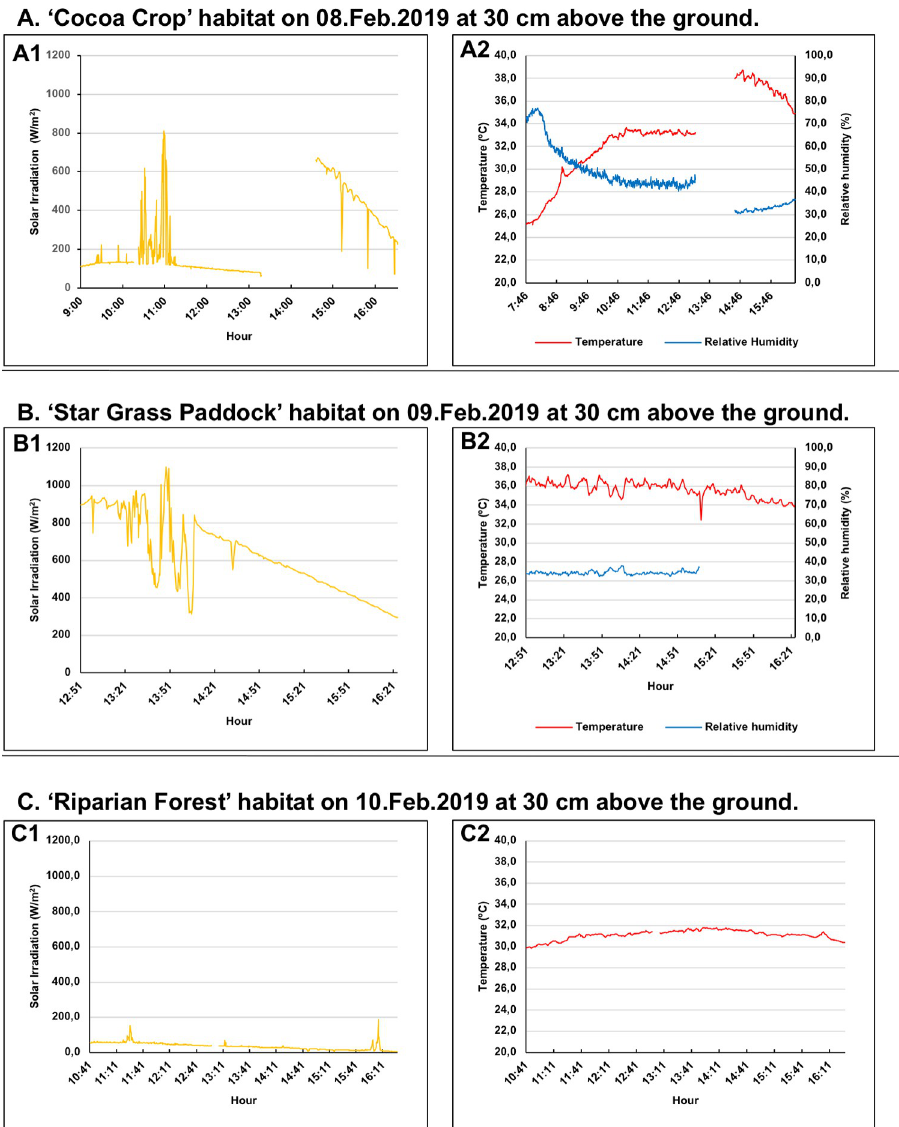
Fig 6. Plots of microclimatic variables that were measured in situ for three habitats in the dry season. (A). Cocoa Crop habitat. (A1). Solar irradiation values (W/m 2 ) (N = 736; � w � = 243.5; SD = 189.1; Max = 810.6; Min = 59.4) according to the daytime hours. (A2). Temperature values (˚C; red line) (N = 901; � w � = 32.7; SD = 3.6; Max = 38.7; Min = 25.1) and relative humidity (%; blue line) (N = 901; � w � = 45.9; SD = 11.6; Max = 76.9; Min = 30.4) according to the daytime hours. (B). Star Grass Paddock habitat. (B1). Solar irradiation values (W/m 2 ) (N = 427; � w � = 629.1; SD = 199.6; Max = 1,096.9; Min = 295.6) according to the daytime hours. (B2). Temperature values (˚C; red line) (N = 427; � w � = 35.6; SD = 0.8; Max = 37.2; Min = 32.4) and relative humidity (%; blue line) (N = 276; � w � = 34.4; SD = 1.0; Max = 38; Min = 32.3) according to the daytime hours. The relative humidity variable was not measured during the same period of time than temperature because of a damage in the respective sensor. (C). Riparian Forest habitat. (C1). Solar irradiation values (W/m 2 ) (N = 677; � w � = 36; SD = 19.8; Max = 189.6; Min = 6.9) according to the daytime hours. (C2). Temperature values (˚C) (N = 677; � w � = 31.1; SD = 0.4; Max = 31.8; Min = 29.9) according to the daytime hours. The relative humidity variable was not measured because of a damage in the respective sensor. S5 Table). The thermal tolerance reported for A . mixtum coincides with our observations, where the temperature fluctuates strongly between the two seasons of the year studied (the dry season in February/2019 vs. the wet season in August/2019). In the Yopal region, the average